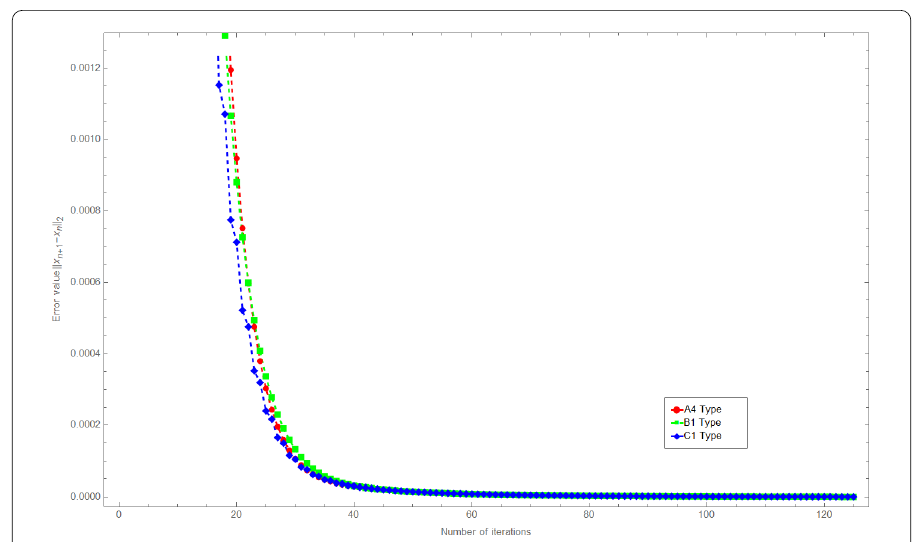
Figure 8 Convergence behavior of the error sequences {(cid:13) x n +1 – x n (cid:13) 2 } for all the best choice types A4, B1 and C1 in example 4.10